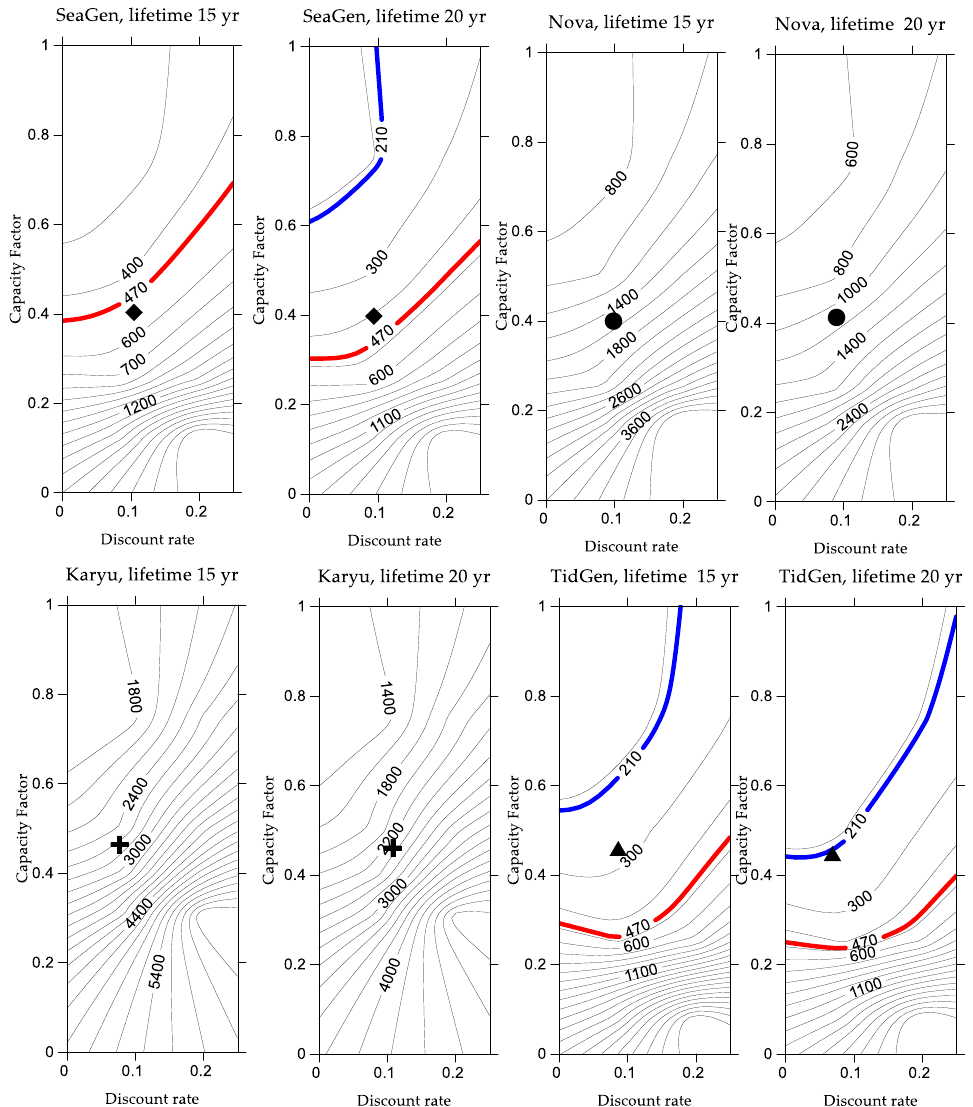
Figure 7. Theoretical representation of LCOE (USD/MWh) scenarios for the turbines, considering two lifetimes (15 and 20 years), and varying discount rates (r) from 0 to 0.25, and the Capacity Factor from 0 to 1. The public CAPEX and OPEX values were used. The maximum and minimum international LCOE value is shown in the blue and red lines, respectively [68]. The symbols rhombus (cid:117) , circle (cid:108) , cross (cid:58) , and triangle (cid:78) show the LCOE at a Capacity Factor of 0.4, at a discount rate of 0.1 and with public CAPEX, respectively.